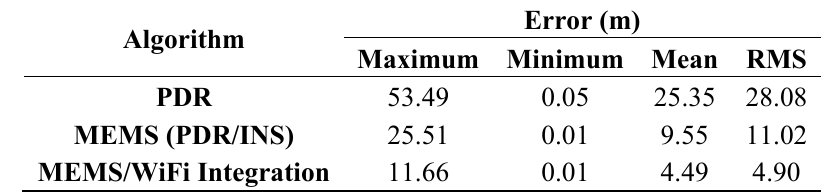
Figure 14. WiFi trajectory (Trajectory III). Table 3. Positioning performance of different algorithms in Trajectory